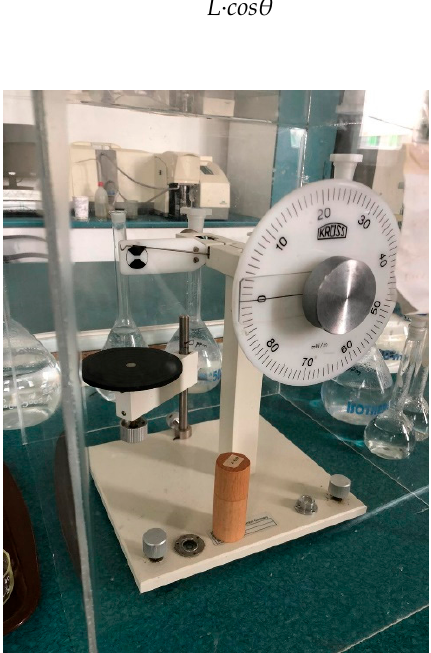
Figure 4. Du-Noüy surface tension ring unit.